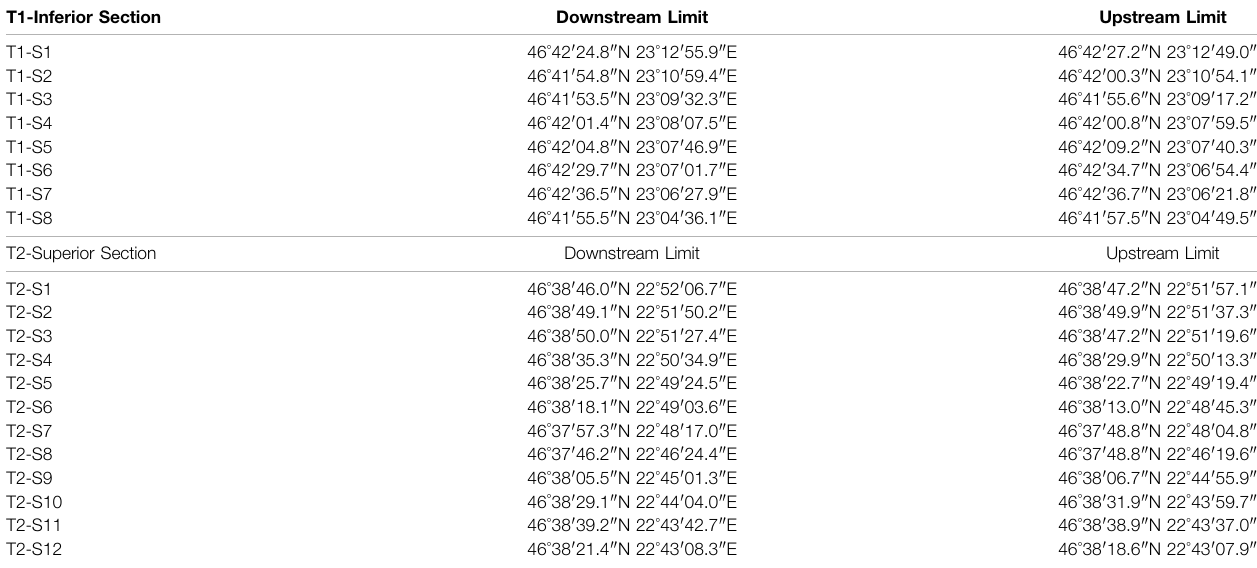
TABLE 2 | GPS coordinates of the sampling